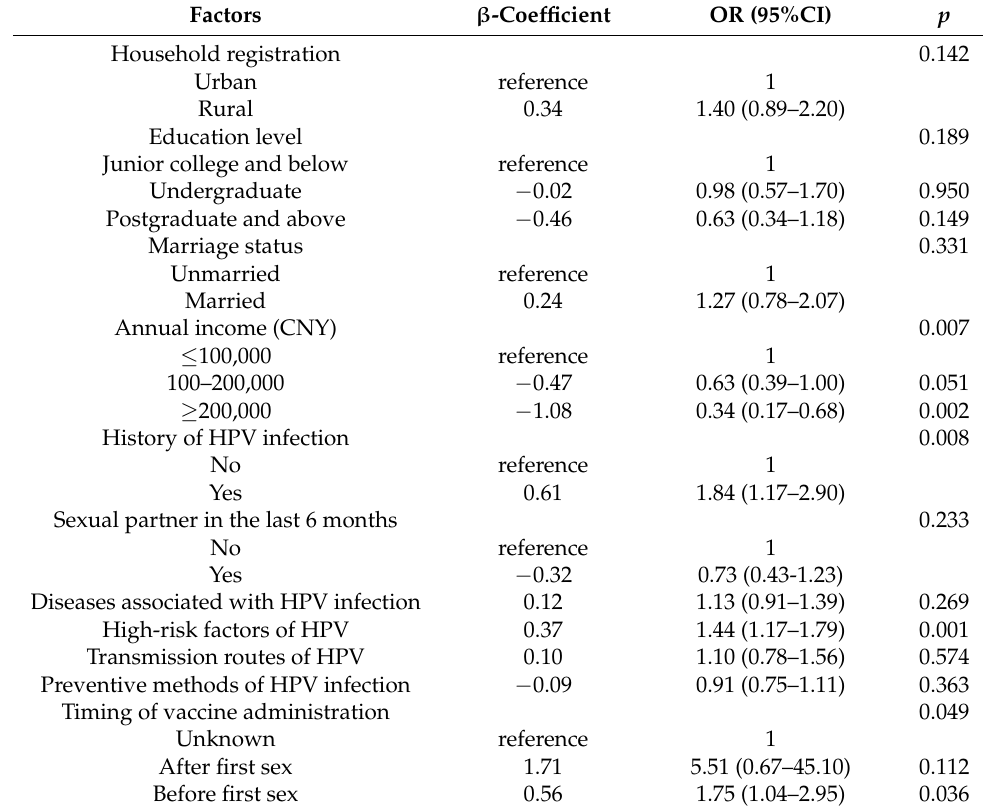
Table 5. Multivariable analysis of factors influencing men’s attitudes toward HPV vaccine in males being included in the national immunization